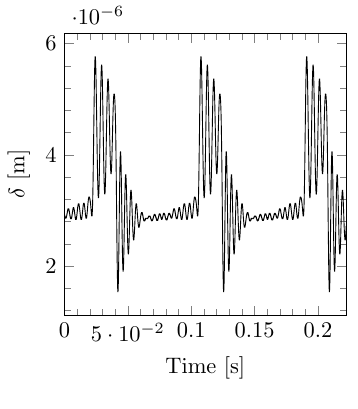
thin-banded peaks in Figure 9b occur at the constant meshing frequency ω m = Ω d its multiples, where z is the number of teeth of the driving gear.